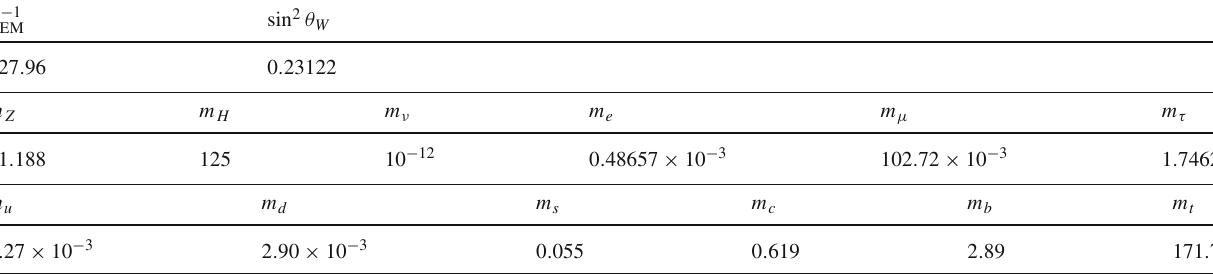
Table 1 Input parameters. Masses of Z boson, the Higgs boson, leptons and quarks in the unit of GeV at the Z mass scale